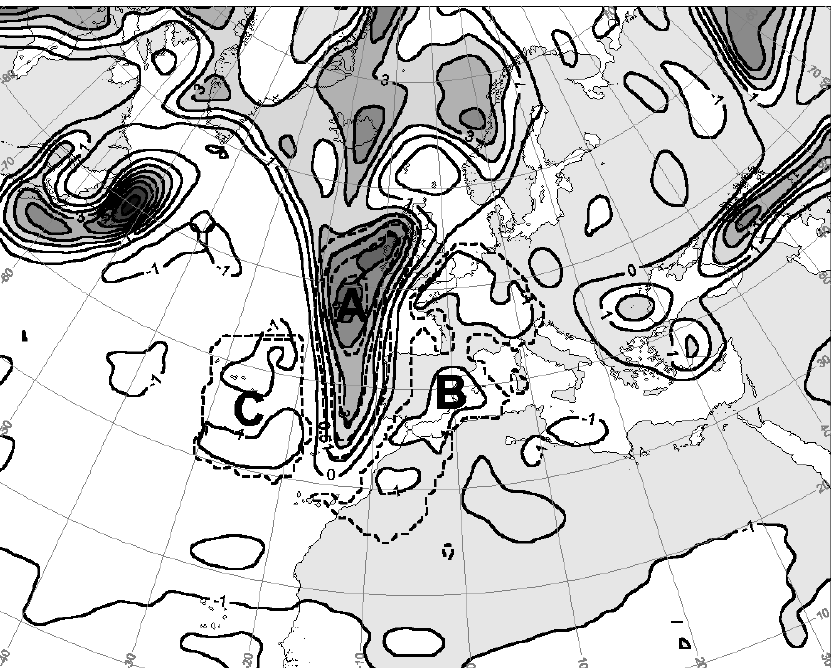
Fig. 21. PV perturbation field